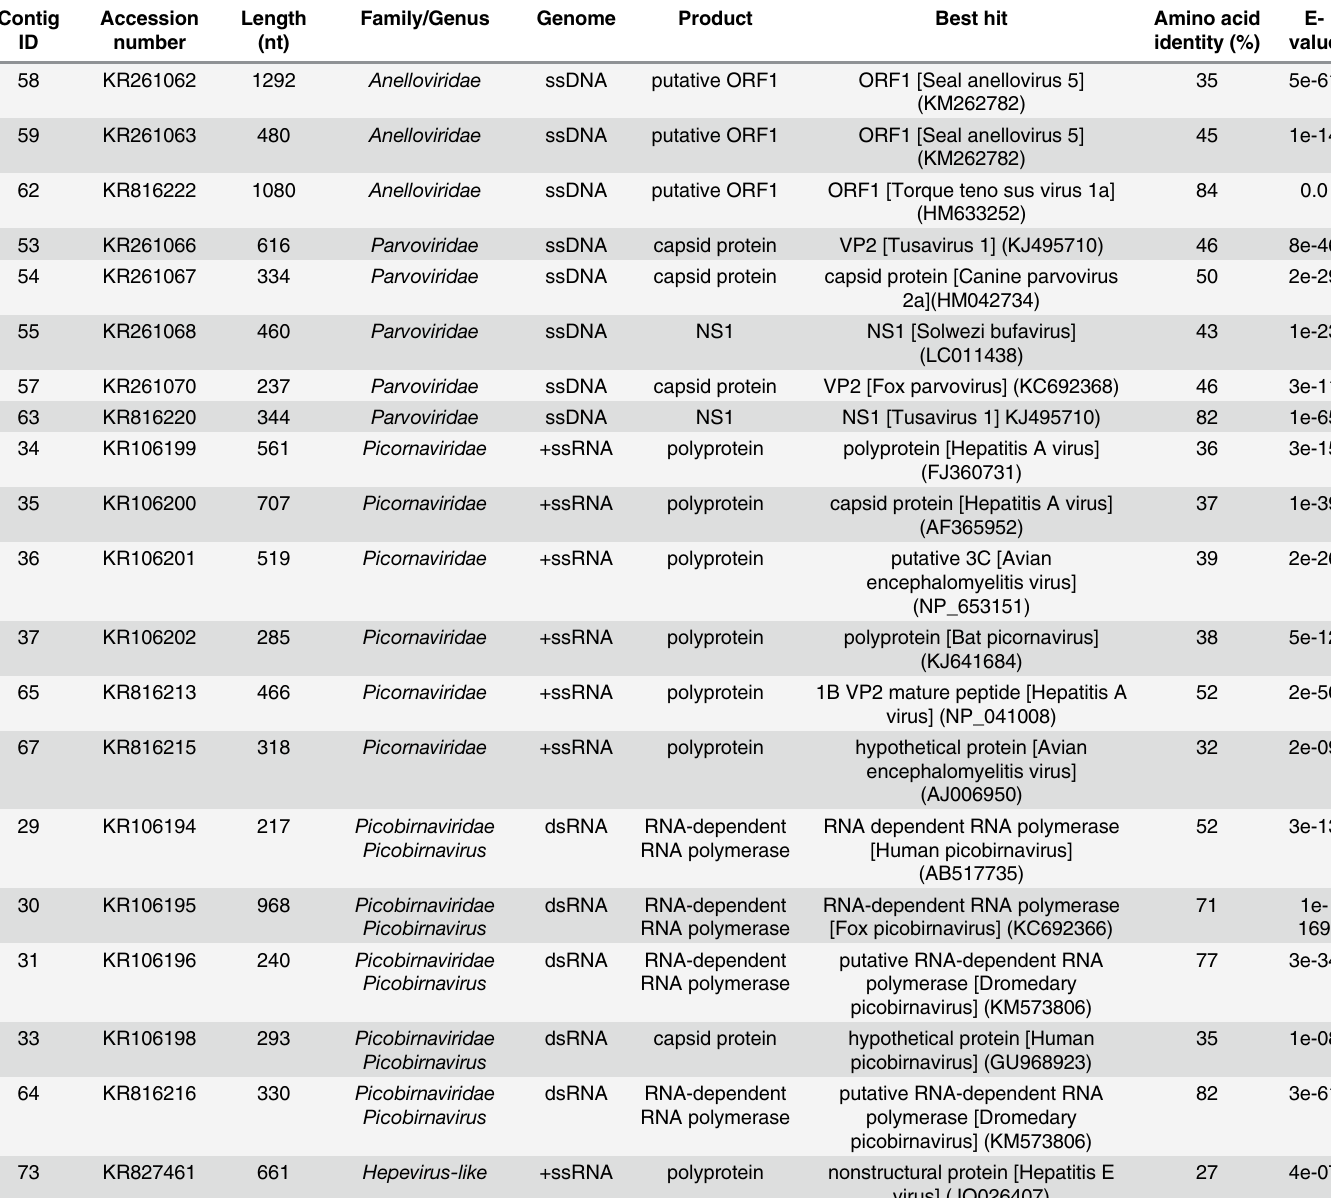
Table 2. Contigs ( > 200bp) with significant BLASTx hits to known eukaryotic viruses obtained from the South American fur seals ( Arctocephalus australis